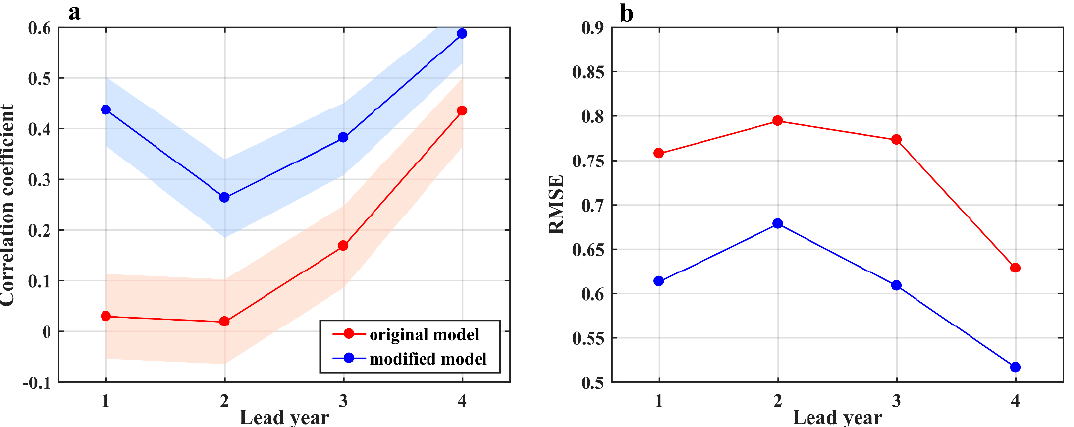
Figure 5. The ( a ) ACC with the shaded area in indicating the 95% confidence interval and ( b ) RMSE of the PDO index between the observation and the prediction for 1965–2010. The red and blue lines represent the observation and predicted results of original and modified FIO − ESM − CPS for 1- to 4-year lead times (unit: 1).